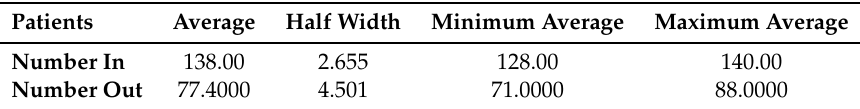
Table 2. Number of patients in/out.